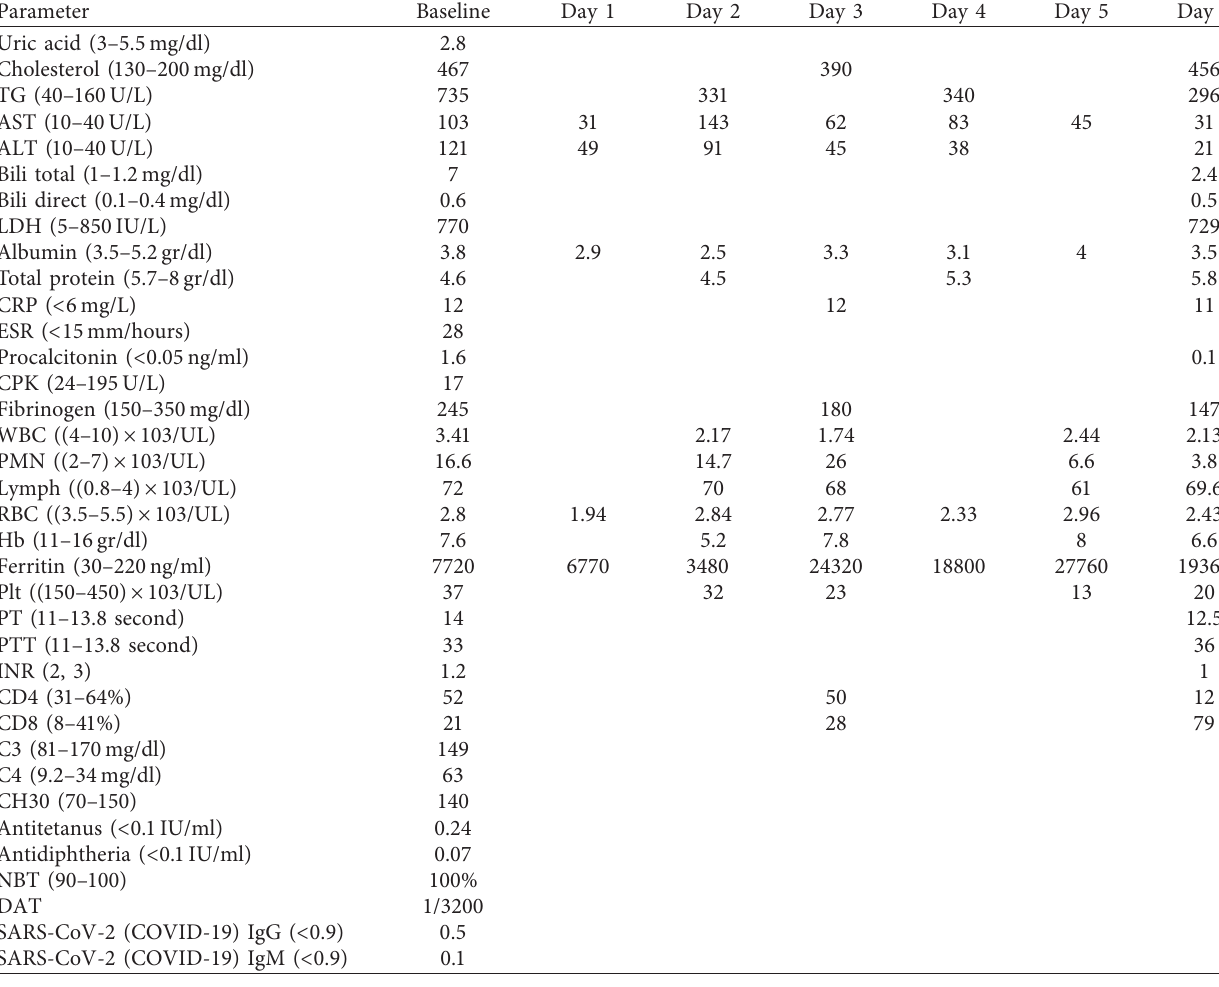
Table 1: Laboratory findings of the patient during admission.